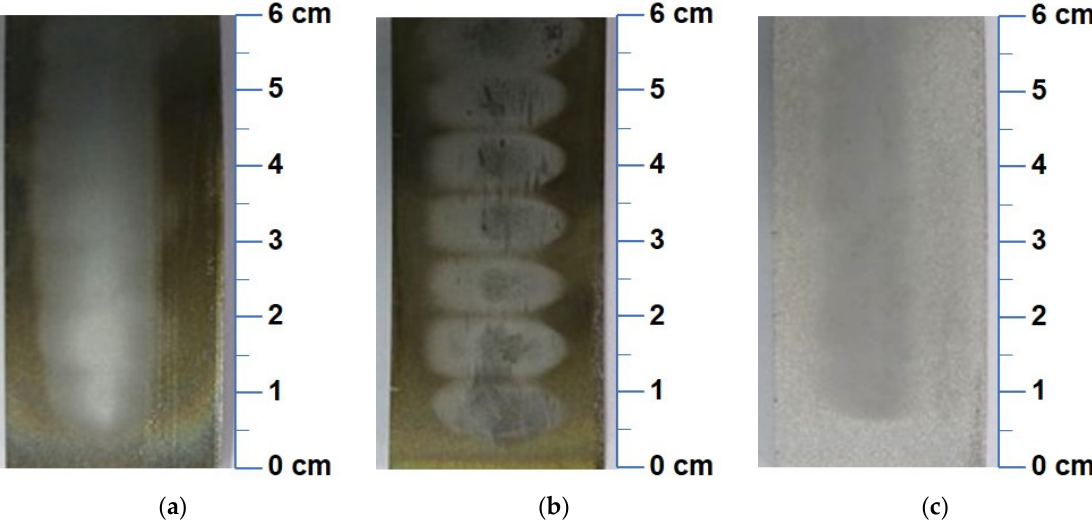
Figure 14. Polishing effect of three types of materials : ( a ) aluminum; ( b ) medium carbon steel; ( c ) stainless-steel.